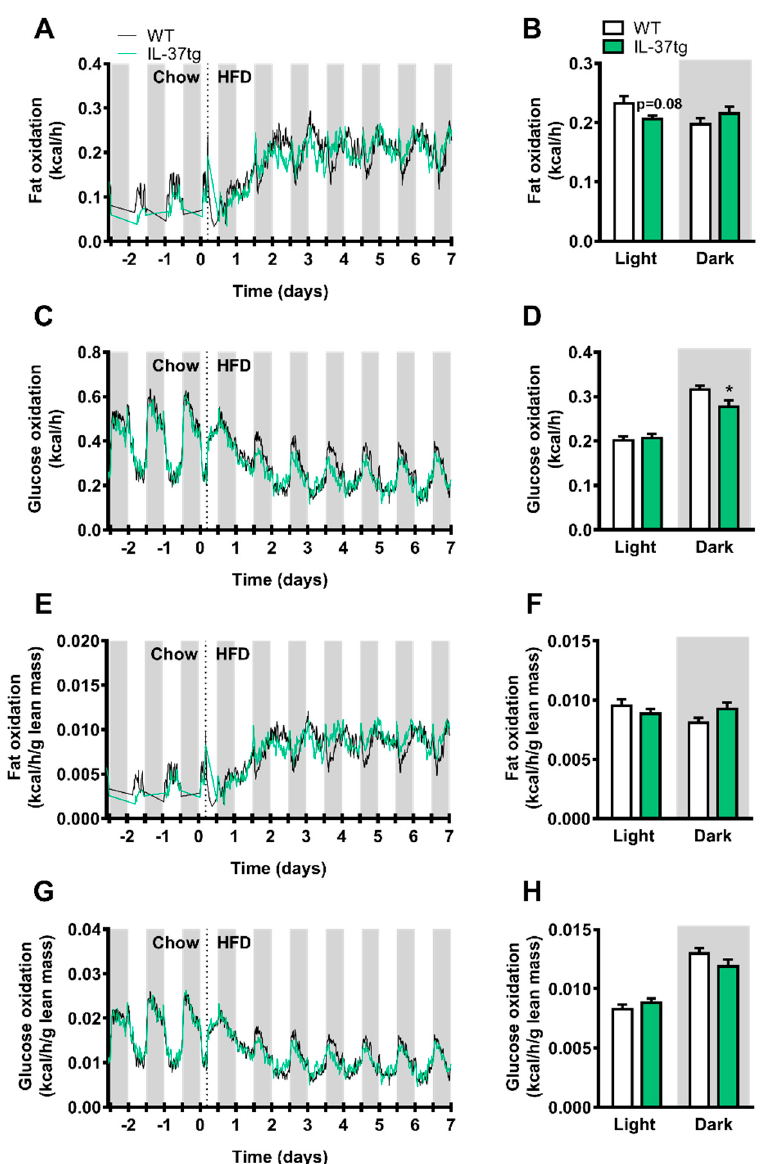
Figure 4. Heterozygous IL-37 expression decreases glucose oxidation in conjunction with lean body mass reduction. 10-week old male C57Bl/6J mice and heterozygous IL-37tg mice on a C57Bl/6J background were fed a high-fat diet (HFD). From 2 days before initiation of HFD until 1 week after the switch to HFD, mice were housed in fully automatic metabolic cages, which measured oxygen uptake (V O2 ) and carbon dioxide production (V CO2 ). Fat ( A , B ) and glucose ( C , D ) oxidation was calculated and were corrected for lean mass (fat oxidation; E , F ; glucose oxidation; G , H ). Bar graphs were based on calculations of the mean from day 1.5 to 7. Values represent means ( A , C , E , G ) and bar graphs represent means ± SEM ( B , D , F , H ) ( n = 8 animals per group). * p < 0.05 IL-37tg vs. wild-type (WT).